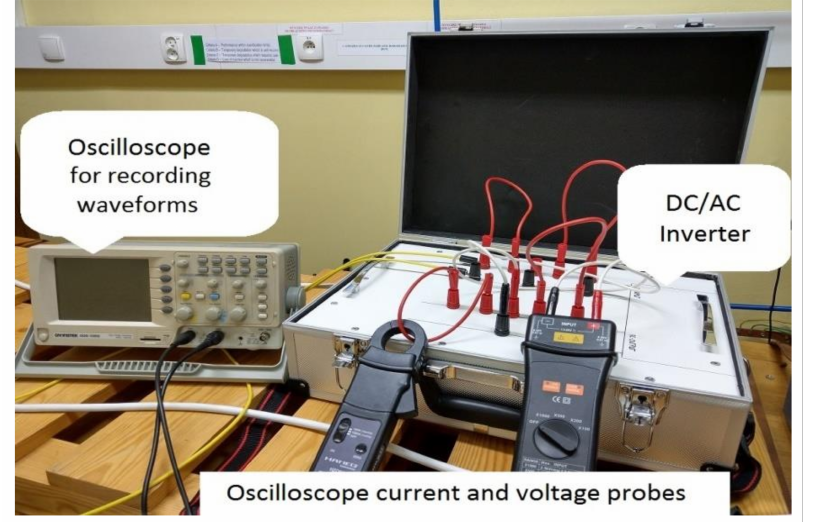
Figure 15. The second part of the test stand, consisting of a microinverter, voltage and current probes, and an